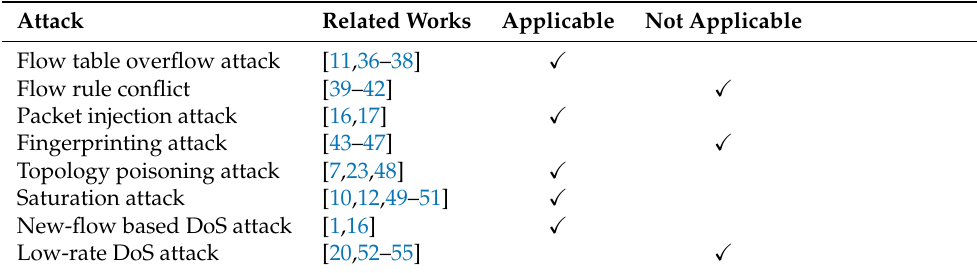
Table 4. Applicability of